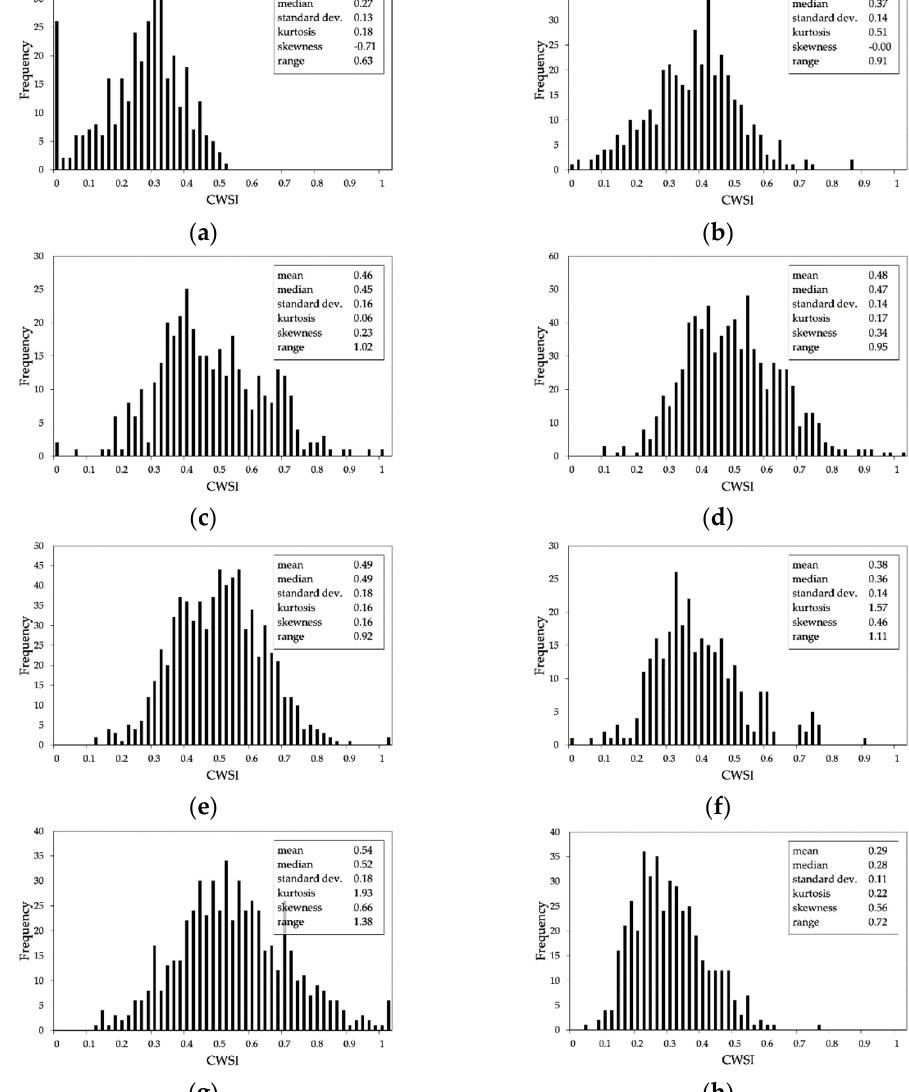
Figure 14. Distribution of the CWSI values within each SSMZ shown in Figure 12a: ( a ) SSMZ 1; ( b )